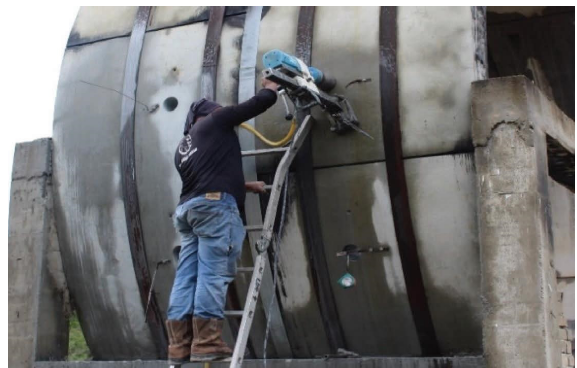
Figure 5: Drilling cores in the full-scale segments for MYC and SPC concrete.